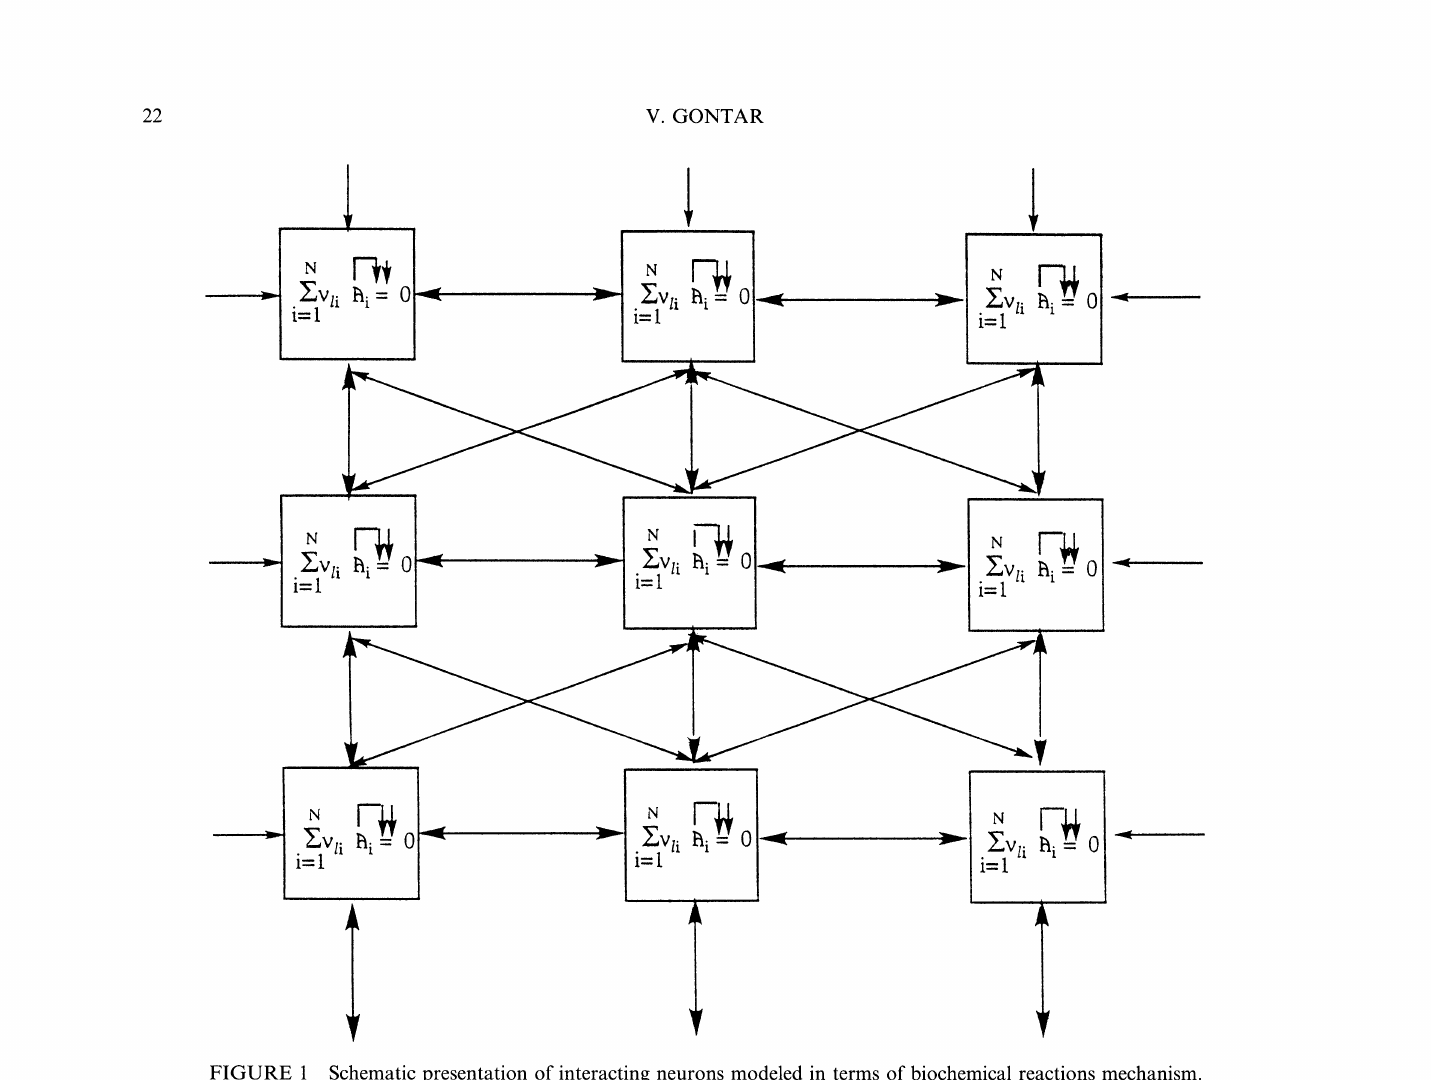
FIGURE Schematic presentation of interacting neurons modeled in terms of biochemical reactions